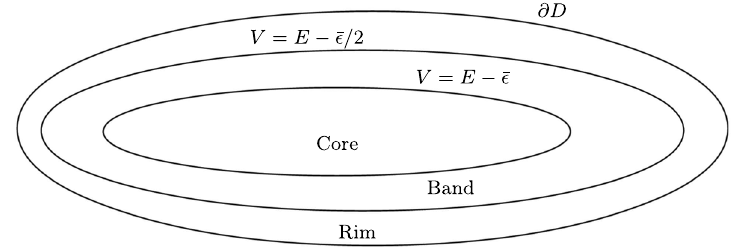
Figure 3: The division of the potential well D into the rim, the band and the